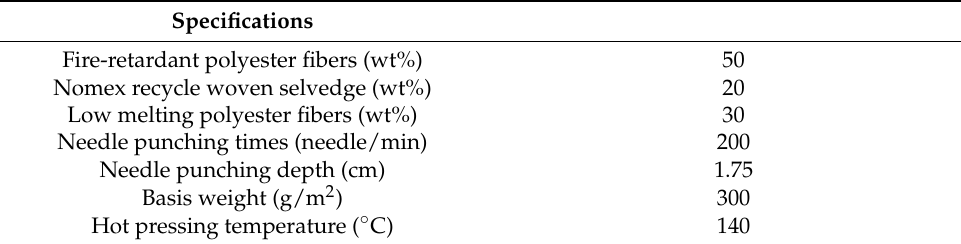
Figure 1. Manufacturing process diagram for nonwoven fabrics that involves with ( a ) the hopper feeder; ( b ) carding machine; ( c ) Folding machine; ( d ) transmission band; ( e ) needle punching ma- chine; ( f ) Drum heat press. Table 1. Manufacturing parameters of nonwoven fabrics. Table 1. Manufacturing parameters of nonwoven fabrics.